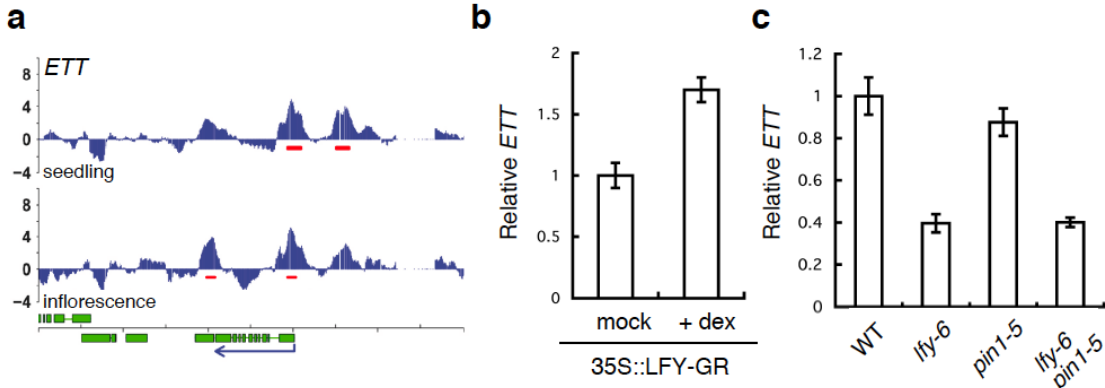
Figure 6. LFY regulates the ETT gene. ( a ) LFY binds to the regulatory regions of the ETT gene based on a published ChIP-chip data set [37]. Screenshots of the LFY binding peaks (blue vertical lines). Significant LFY-binding peaks are indicated by a red horizontal line below the peaks. Green boxes below the graphs denote exons, blue arrows indicate the direction of transcription; ( b ) Expression of the ETT gene based on qRT-PCR three hours after mock or dexamethasone (dex) treatment of lfy-6 35S::LFY-GR inflorescences ( c ) Expression of the ETT gene based on qRT-PCR in lfy-6 null mutant, weak pin1-5 mutant, and pin1-5 lfy-6 double mutant inflorescence apices compared to wild-type inflorescence apices. RNA from floral bud clusters (containing stages 1-6 flowers) was used in this